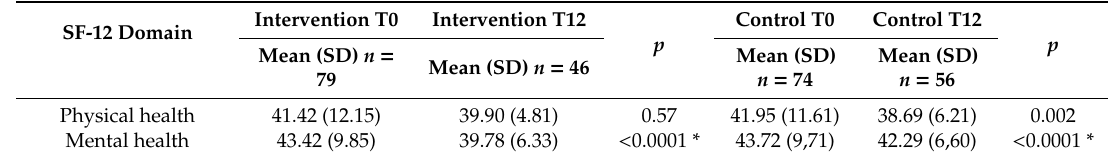
Table 3. Scores of intervention and control group on SF-12 at di ff erent timepoints.